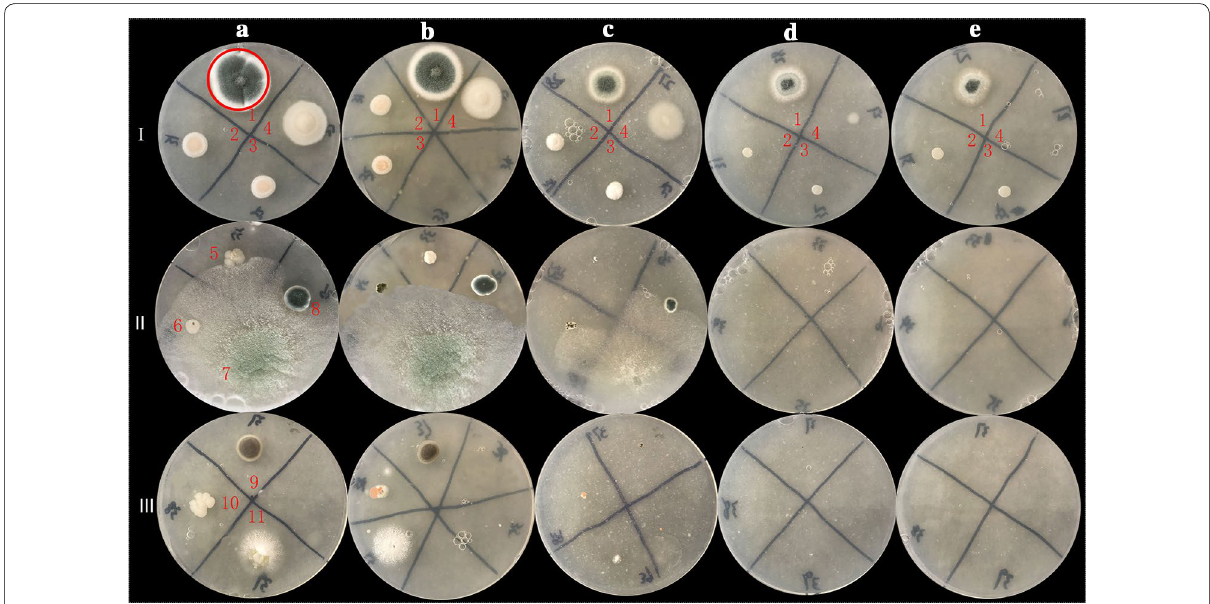
Fig. 1 Effects of different concentrations of Y 3 + on fungal growth. The concentration of Y 3 + in column of a – e were 10, 100, 200, 400 and 800 mg/L, respectively; the line I, II and III contain strains number 1–4, 5–8, 9–11, respectively. The strain number 1 in red circle is the target fungus, identified Penicillium sp.